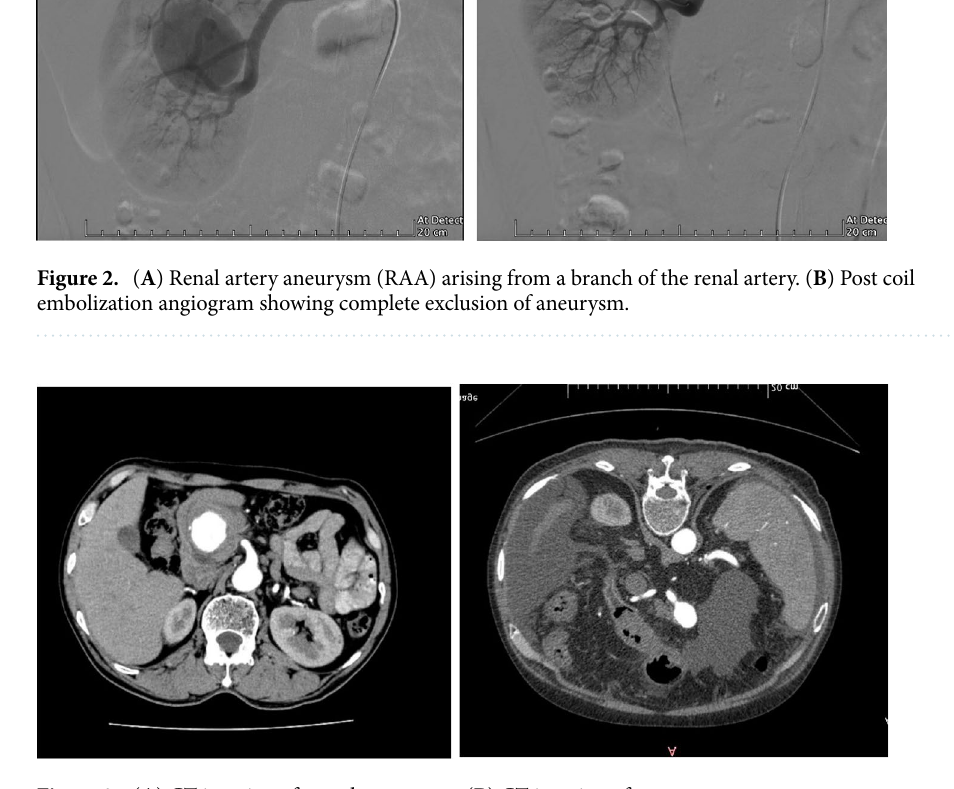
Figure 3. ( A ) CT imaging of pseudoaneurysm. ( B ) CT imaging of true